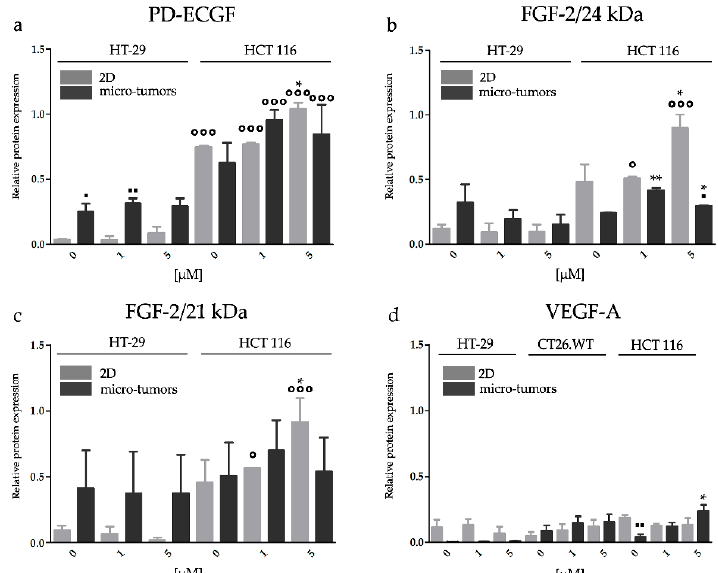
Figure 8. Effect of HP on the pro-angiogenic factors protein expression of PD-ECGF ( a ), FGF-2/24 kDa ( b ), FGF-2/21 kDa ( c ), and VEGF-A ( d ). HP could potentiate the expression of angiogenic proteins already 24 h after treatment. The proteins were analyzed by Western blot. The effect of HP on PD-ECGF, FGF-2, and VEGF-A expression in cells cultivated in 2D and micro-tumor cell models was analyzed 24 h after treatment. β -actin served as a loading control. The groups treated with HP were compared with untreated control (* p < 0.05, ** p < 0.01). The experimental micro-tumors and cells cultivated in 2D cell model were compared with each other ( (cid:4) p < 0.05), so were the particular cell lines ( 0 p < 0.05, < 0.001). Data were analyzed with one-way ANOVA with Tukey’s post-test or t 000 p